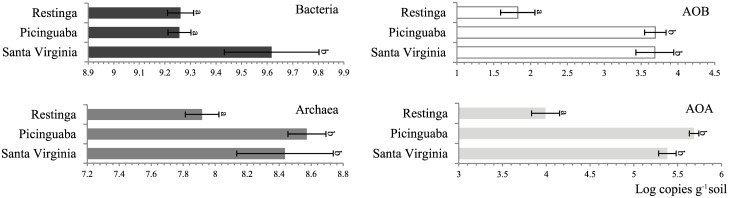
Quantification of targeted fractions—Bacteria, Archaea, AOA and AOB—of the soil microbiome in the three Atlantic Rainforest areas.Bars indicate average values from four replicates, while error bars indicate standard deviations. Bars labeled with the same letter in each graph do not differ statistically according to Tukey’s test (p > 0.05).